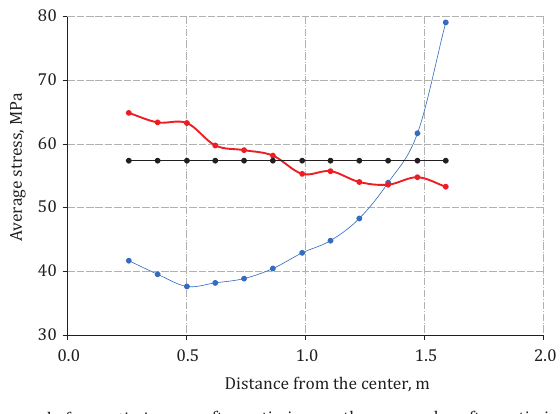
and the optimal model based on finite element analysis